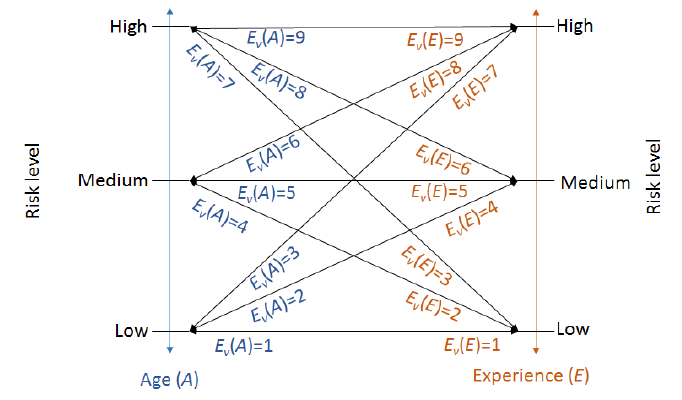
Figure 2. Risk scenarios for age and